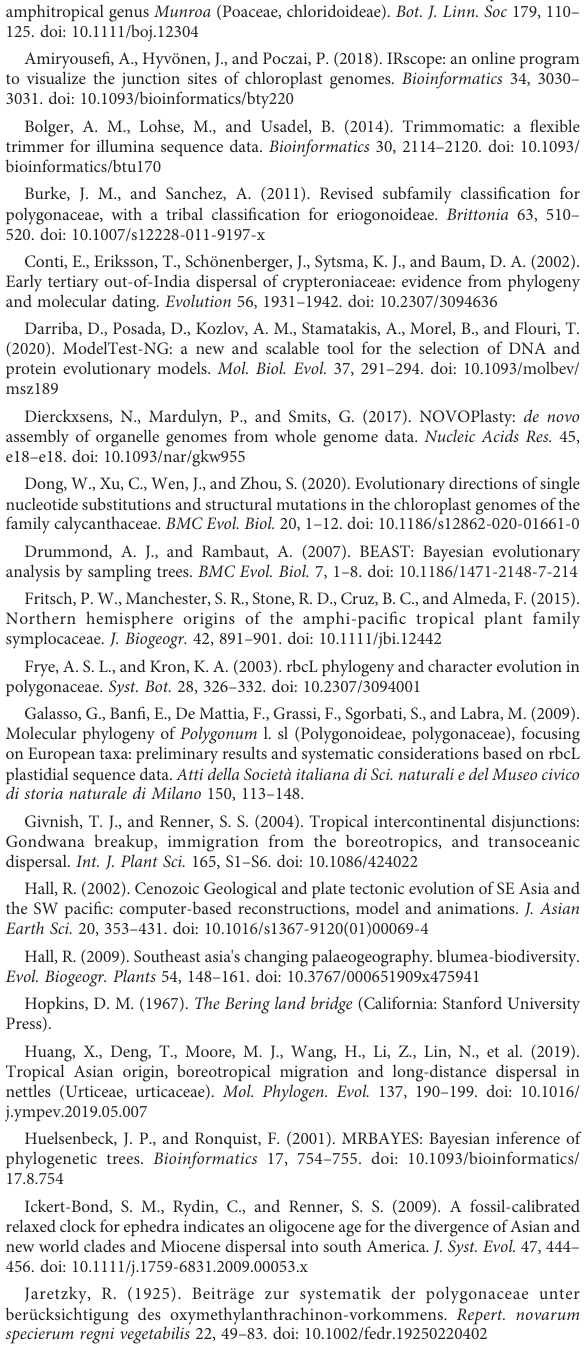
copy of the IR regions. Maximum likelihood bootstrap values (BS) and posterior probabilities (PP) are shown at nodes. Branches with no values listed have 100% BS and PP of 1.0.